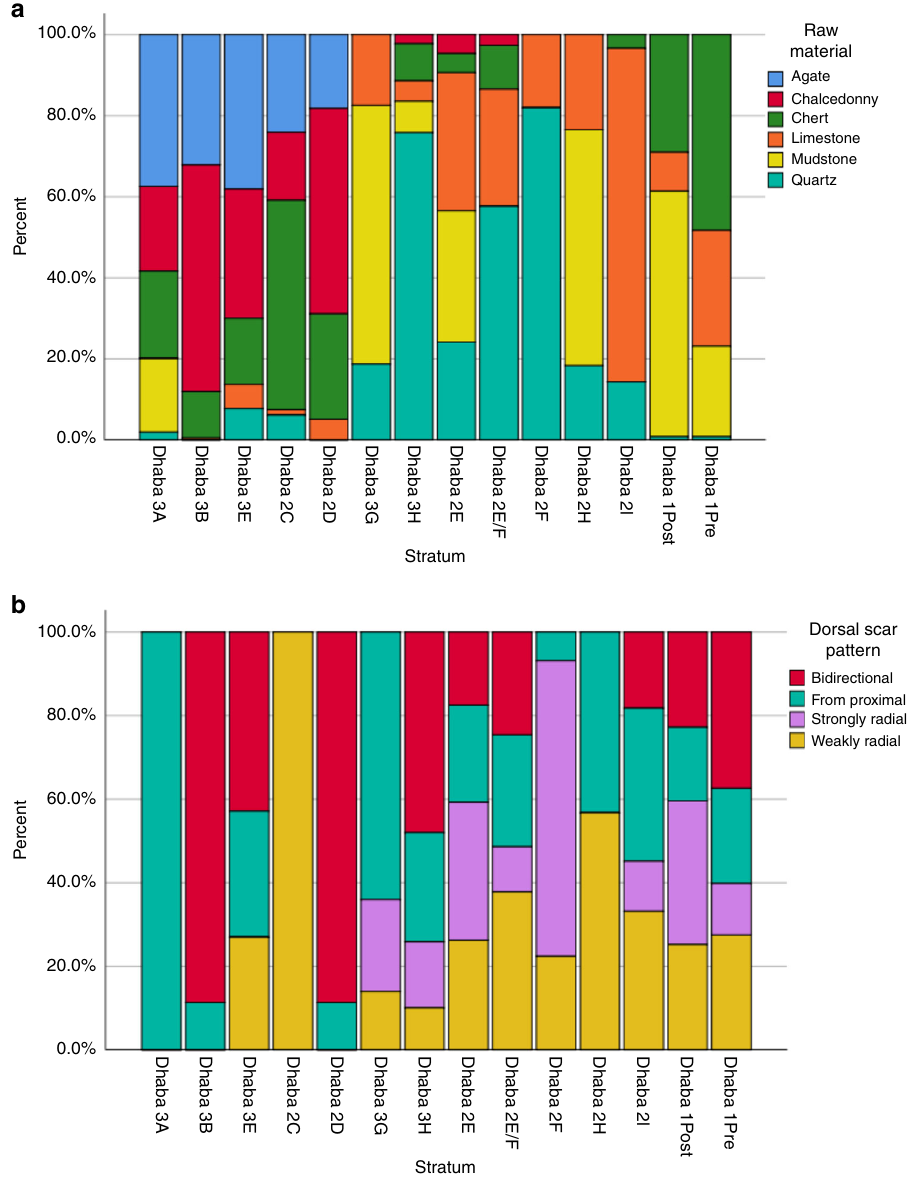
Fig. 5 Key raw material and technological changes at Dhaba from 80 to 25 ka (left to right = younger to older). a Raw material changes as a proportion of all artefacts by stratum (Pearson chi-square = 892.4; N = 9; N = 3512; p = < 0.005). b Changes in proportions of scar patterning for all complete fl akes by stratum (Pearson chi-square = 37.02; df = 9; N = 797; p = < 0.005 one-sided). Bidirectional scar patterns originate from the proximal (platform) and distal ends of the core or fl ake. Proximal scar patterns originate from the proximal/platform end only. Strongly radial scar patterns originate in a centripetal pattern around the margins of the fl ake or core, while weakly radial scar patterns are those with scars that originate from several points around the fl ake or core circumference but are too few in number (<4) to determine a strong centripetal pattern. Source data are provided as a Source Data fi